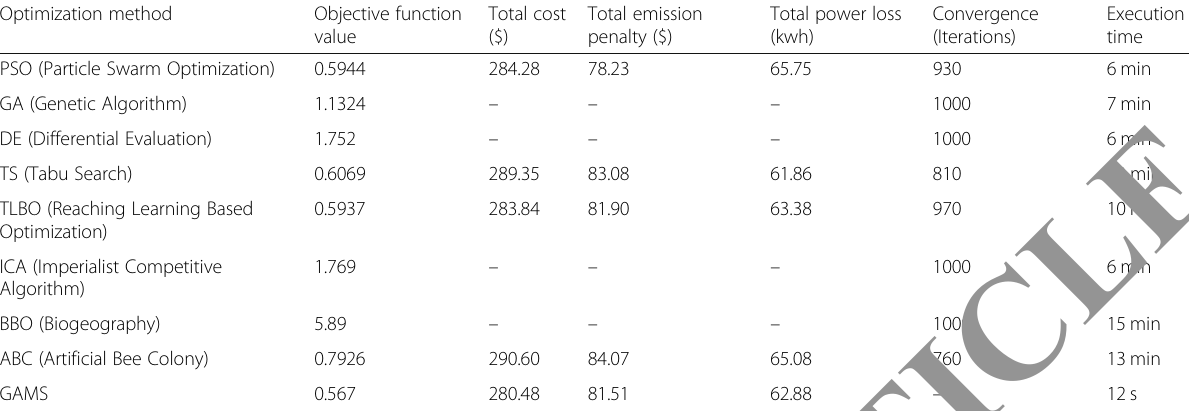
Table 3 Comparison of evolutionary algorithms for MGEM Optimization method